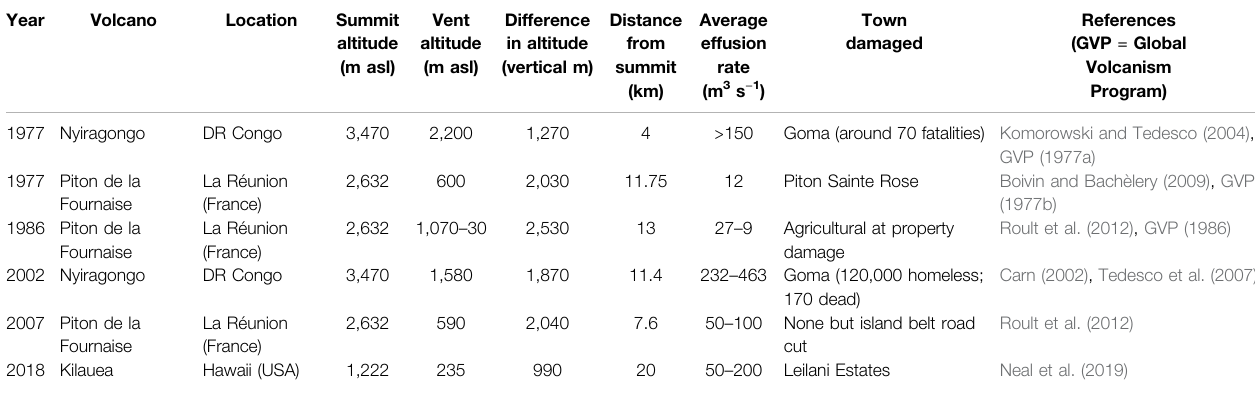
TABLE 1 | Damage-causing low fl ank effusive eruptions between 1977 and 2020. All summit altitudes are from the GVP (Global Volcanism Program 2013), distances from summit are from Google